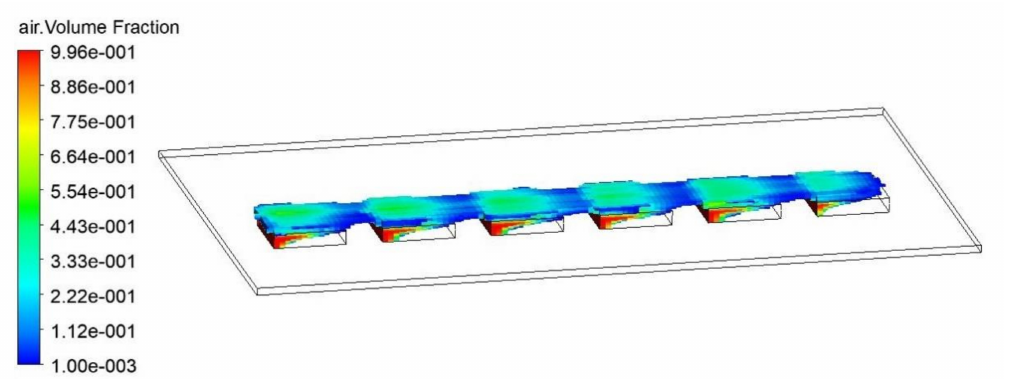
Figure 16. The air volume fraction is generated by a full texturing configuration with dimples side 50 µ m and gap 5 µ m, sliding velocity 5 m / s. Set B of the cavitation coe ffi cient. Only the portions of the mesh where the volume fraction of air is greater than 1% (cid:24) are highlighted.